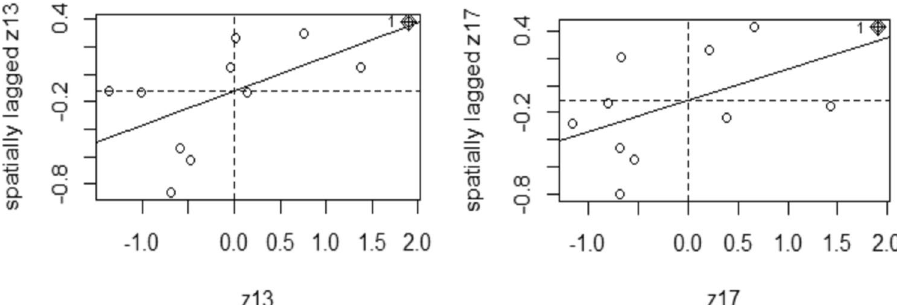
Figure 3. Local Moran scatter diagram in 2013 and 2017. It represents a form of spatial connection surrounded by regions. Moran scatter diagram consists of four quadrants. The points in the first and third quadrants (i.e. the upper right one and the lower left one) indicate that high values are surrounded by high values and low values are surrounded by low values, respectively, which means that areas with similar attributes are clustered together. The points in the second and fourth quadrants (i.e. the upper left one and the lower right one) indicate that high values are surrounded by low values or low values are surrounded by high values, which means that areas with different attributes are clustered together 36 . z13 local Moran’s I index in 2013, z17 local Moran’s I index in 2017.